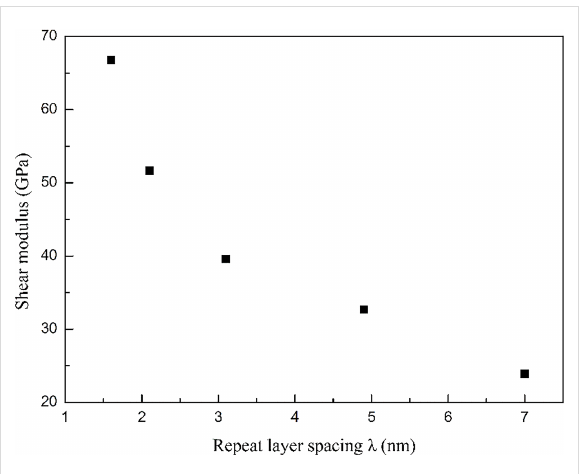
Figure 11: The shear modulus of zigzag GPCuNL composites with dif- ferent repeat layer spacings.